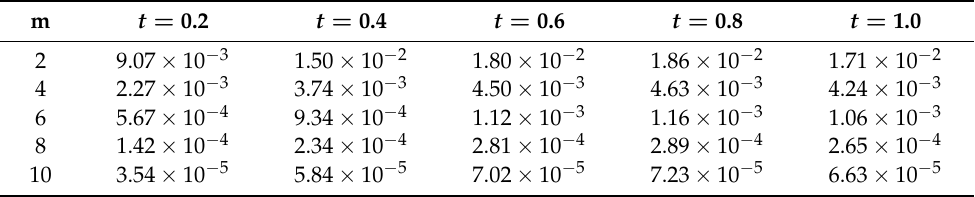
Table 2. L 2 norm of errors taking r = 5, J = 2, θ = 1/2 and δ t = 0.1/2 m − 1 for Example